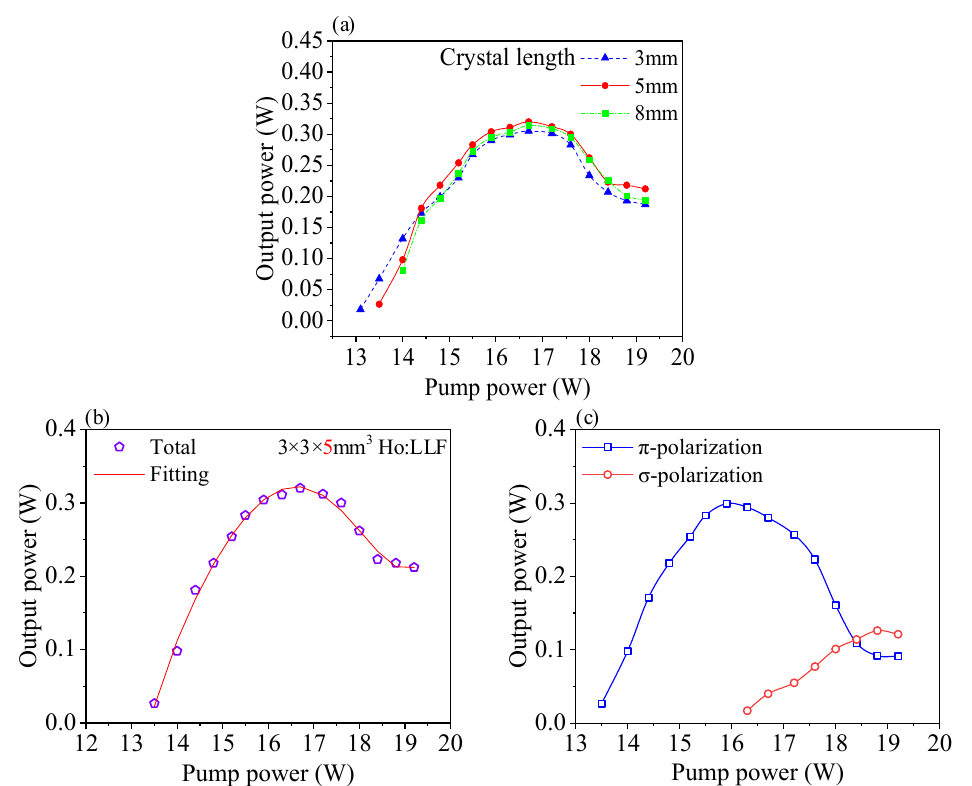
Figure 4. ( a ) The output power and pump power for different crystal lengths (3 mm, 5 mm, and 8 mm); ( b ) the total and ( c ) individual polarization direction output power in the Ho:LLF (crystal length was 5 mm) laser as a function of the incident pump power.